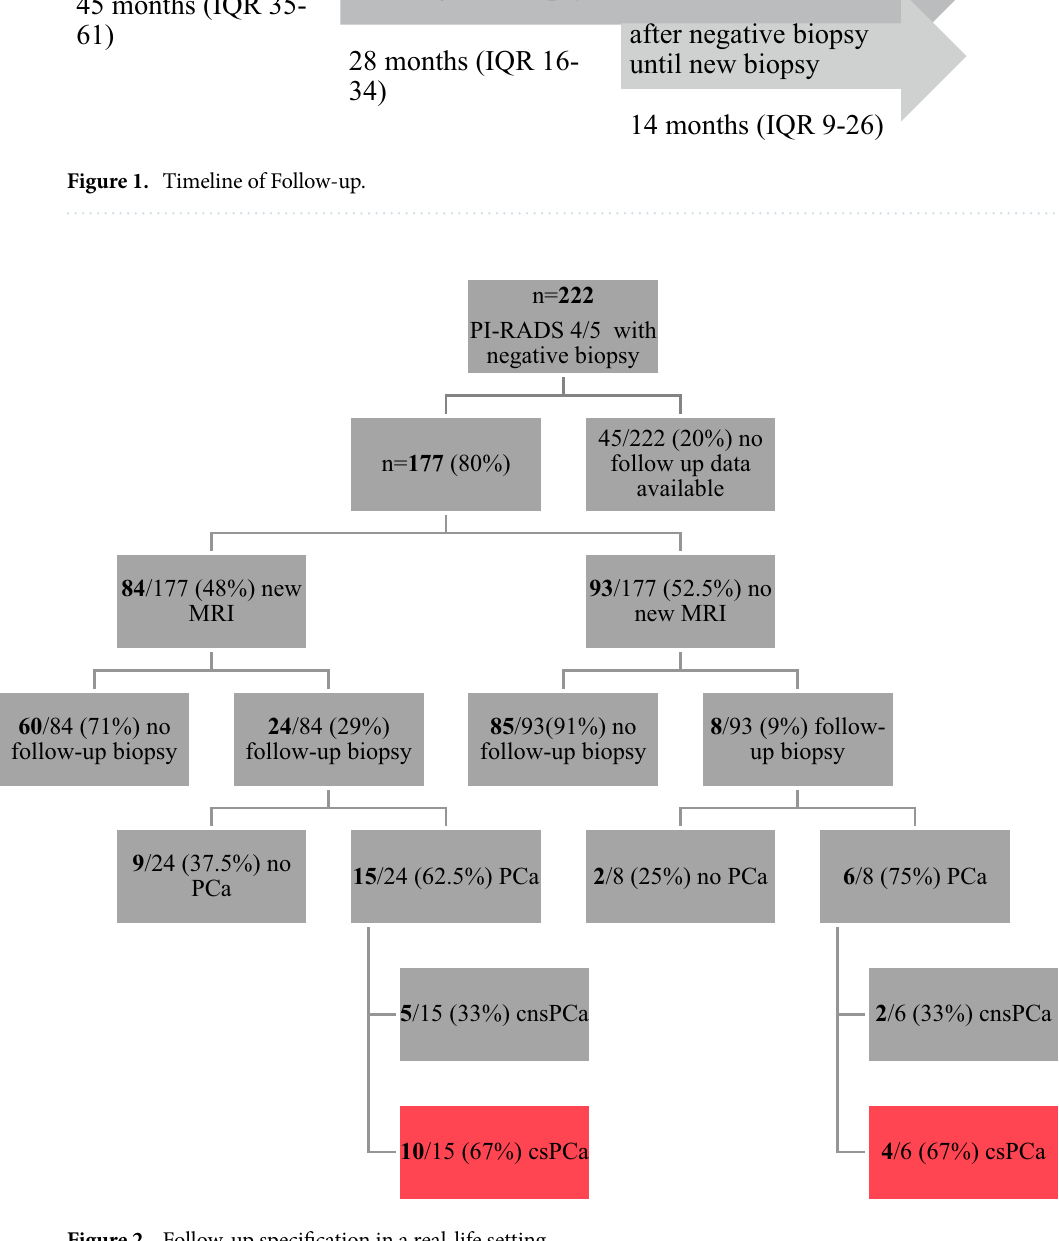
Figure 2. Follow-up specification in a real-life